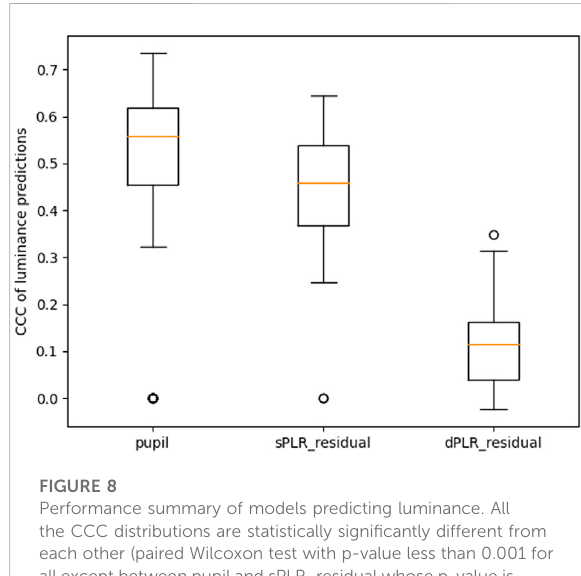
FIGURE 8 Performance summary of models predicting luminance. All the CCC distributions are statistically signi fi cantly different from each other (paired Wilcoxon test with p-value less than 0.001 for all except between pupil and sPLR_residual whose p-value is less than